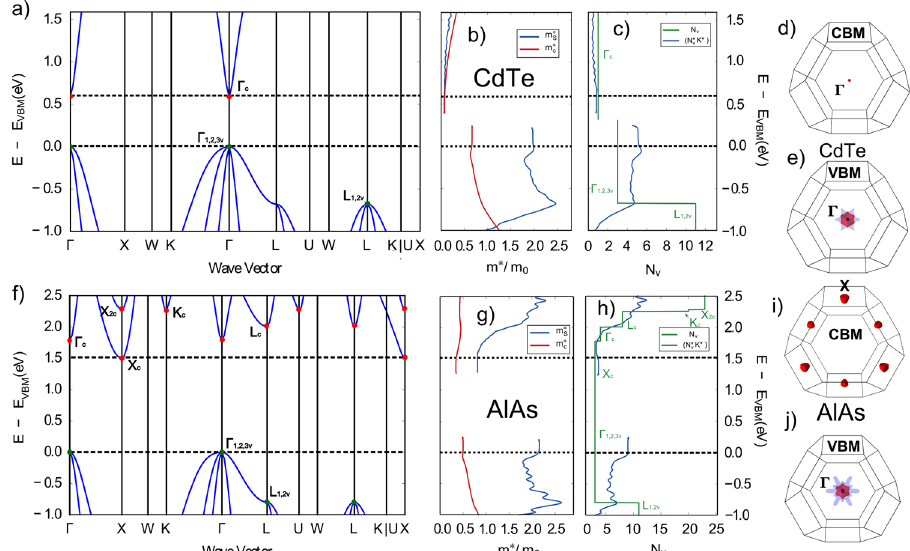
Fig. 1 Effective masses and complexity factor at 300 K from BoltzTraP for some relatively simple structures CdTe ( a – e ) and AlAs ( f – j ). a , f Computed electronic band structure, b , g Conductivity mass, m * c , versus Fermi level and Seebeck DOS mass, m * S , as functions of the Fermi level K * and true valley degeneracy N v. d , i Primary conduction across the valence and conduction bands. c , h Fermi surface complexity factor N * v Fermi surface (0.03 eV above the conduction band edge (CBM) in CdTe and 0.1 eV above the band edge for AlAs), and e , j Valence band Fermi surface (0.05 eV below the valence band edge (VBM) for both CdTe and AlAs). The valence band Fermi surfaces are colored differently for the three degenerate